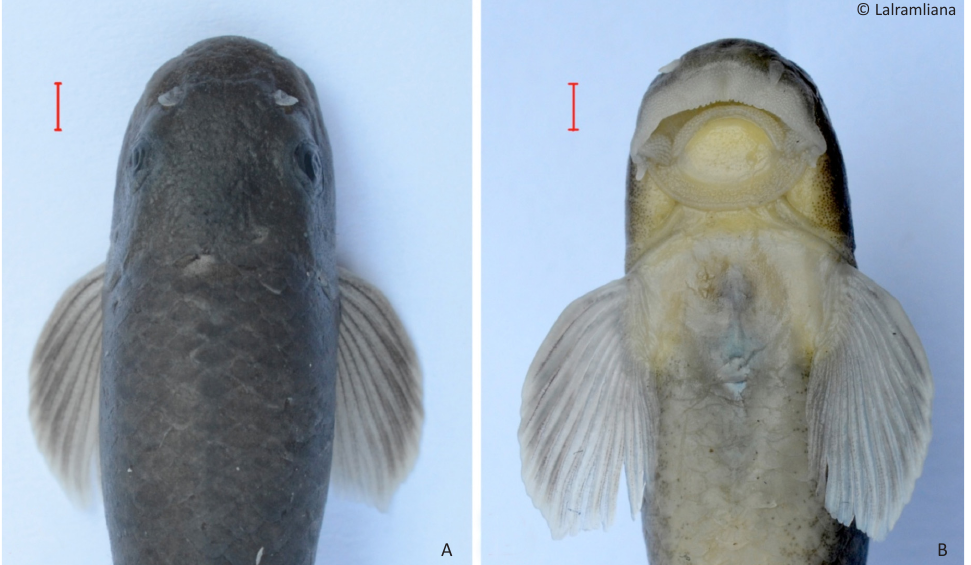
papilliferous tissue on upper jaw. Antero-lateral fold conspicous between upper and lower lip at corner of mouth, not extending mediad between exposed lower jaw and lower lip. Lower lip thick and modified into sucking disc. Disc elliptical, wider than long; anterior